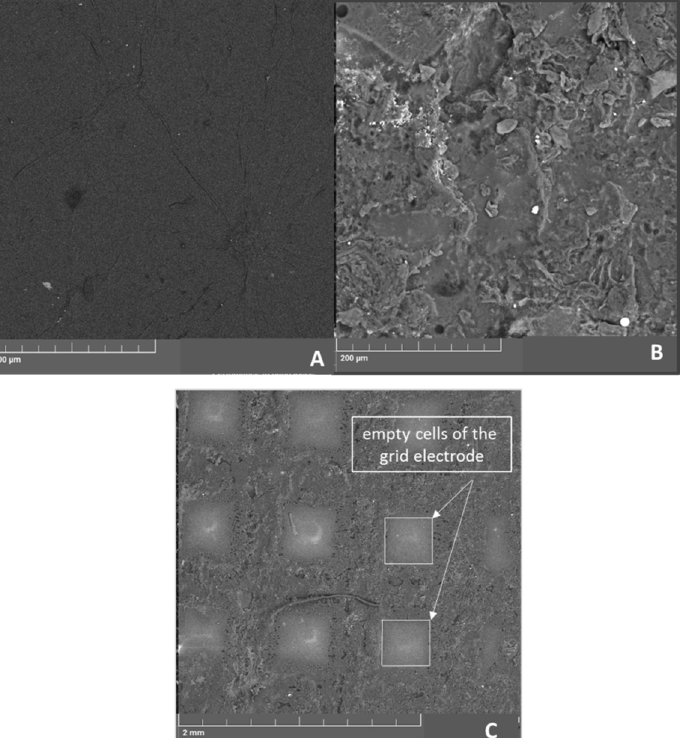
Figure 2. SEM micrographs of ( A ) graphene oxide electrode ( B ) LRGO grid electrode with high resolution ( C ) LRGO gird electrode with low resolution.